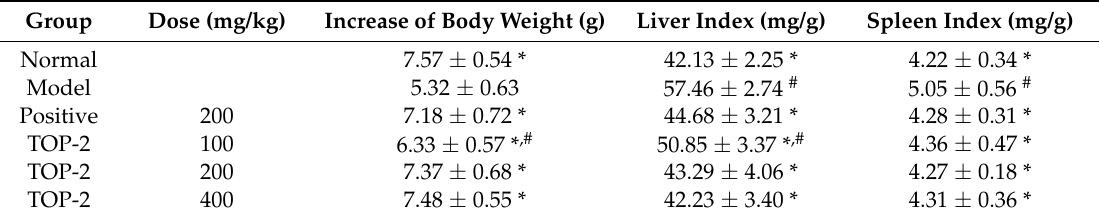
Table 3. Effects of TOP-2 on increase of body weight and organ index in alcohol-induced liver injury